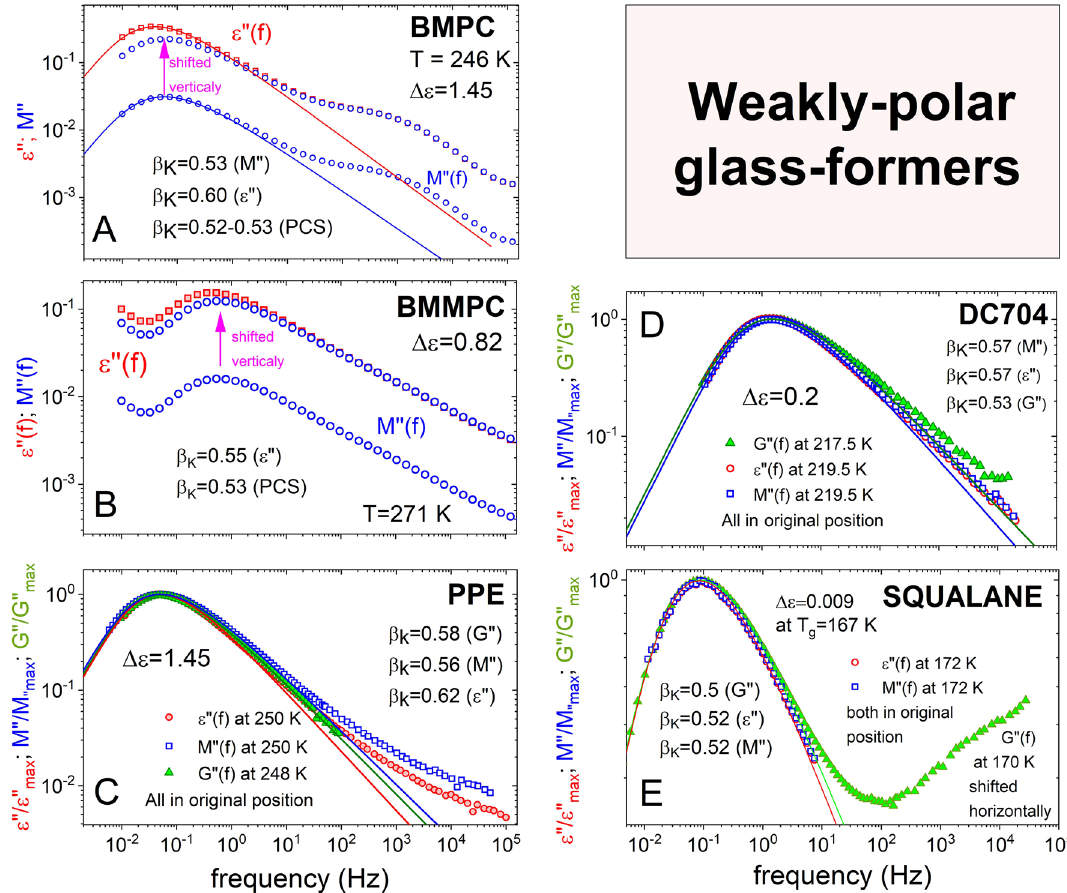
Figure 7. ( A ) Shows the ε ″ ( f ) and M ″ ( f ) data of BMPC at 246 K, and the vertically shifted M ″ ( f ). The K-exponents are β DS K = 0.60, β M K = 0.53, and β PCS K = 0.52–0.53 for the α-relaxation in ε ″ ( f ), M ″ ( f ), and PCS respectively. ( B ) Shows the data of BMMPC. Similar to ( A ), and β DS K = 0.55, β M K ≈ 0.55, and β PCS K = 0.53. ( C ) Shows the normalized ε ″ ( f ), M ″ ( f ), and G ″ ( f ) data of PPE at 250 K and 248 K, and the Kohlrausch fits with β DS K = 0.62, β M K ≈ 0.56, and β G K = 0.58. ( D ) shows the normalized ε ″ ( f ), M ″ ( f ), and G ″ ( f ) data of DC704 at 219.5 K and 217.5 K, and the Kohlrausch fits with β DS K = 0.57, β M K = 0.57, and β G K = 0.53. ( E ) shows the normalized ε ″ ( f ), M ″ ( f ), and G ″ ( f ) data of squalane at 172 K and 170 K, and the Kohlrausch fits with β DS K = 0.52, β M K = 0.52, and β G K = formers in this paper, giving the value of β DS K = 0.60. On the other hand, the fit in the earlier work was not shown and a smaller value of 0.51 was reported and used by Körber et al. 19 . The calculated M ″ ( f ) at 246 K is presented in Fig. 7A. The M ″ ( f ) data are shifted vertically to have the excess loss in M ″ ( f ) coalescing with that in ε ″ ( f ) like done before for KDE in Fig. 1D. The difference in the height of the α-loss peak between the shifted M ″ ( f ) and ε ″ ( f ) is a factor of 1.5 compared to 10 in the case of KDE. The width of the α-relaxation in M ″ ( f ) is still larger than in ε ″ ( f ) as reflected by β M K = 0.53 compared to β DS K = 0.60 53 . The PCS data we consider are not from Meier et al. but from a later work published by the same group in Mainz by Patkowski et al. 55 , again because the more accurate data and analysis performed. The value of β PCS K for PCS decreases on lowering temperature and by extrapolation of the trend its value at T g = 247 K is estimated to be 0.52–0.53 55 . Hence there is good agreement between β M K = 0.53 and β PCS K = 0.52–0.53 of BMPC, in accord with the prediction. 1,1 ′ ‑bis(p‑methoxyphenyl) cyclohexane (BMMPC). The glass-former BMMPC, also referred to in the literature as bis-kresol-C-dimethylether (BKDE) is closely related in chemical structure to BMPC and its T g is 263 K. It has Δε = 0.82 and the value of 0.55 for the dielectric Kohlrausch exponent β DS K at 264.1 K 56 . The smaller value of β DS K =0.55 implies the JG β-relaxation is widely separated from the α-relaxation. The dielectric loss ε ″ ( f ) at 271 K is shown in Fig. 7B together with the calculated M ″ ( f ). The vertically shifted M ″ ( f ) remarkably has the same fre- quency dependence as ε ″ ( f ) except for the slight horizontal shift due to change from susceptibility to modulus. This feature validates the prediction of no broadening in going from ε ″ ( f ) to M ″ ( f ) because the JG β-relaxation is well separated from the α-relaxation and has no effect in broadening the α-relaxation in M ″ ( f ). PCS data of BMMPC were published by Patkowski et al. 55 . The PCS Kohlrausch exponent β PCS K is temperature dependent